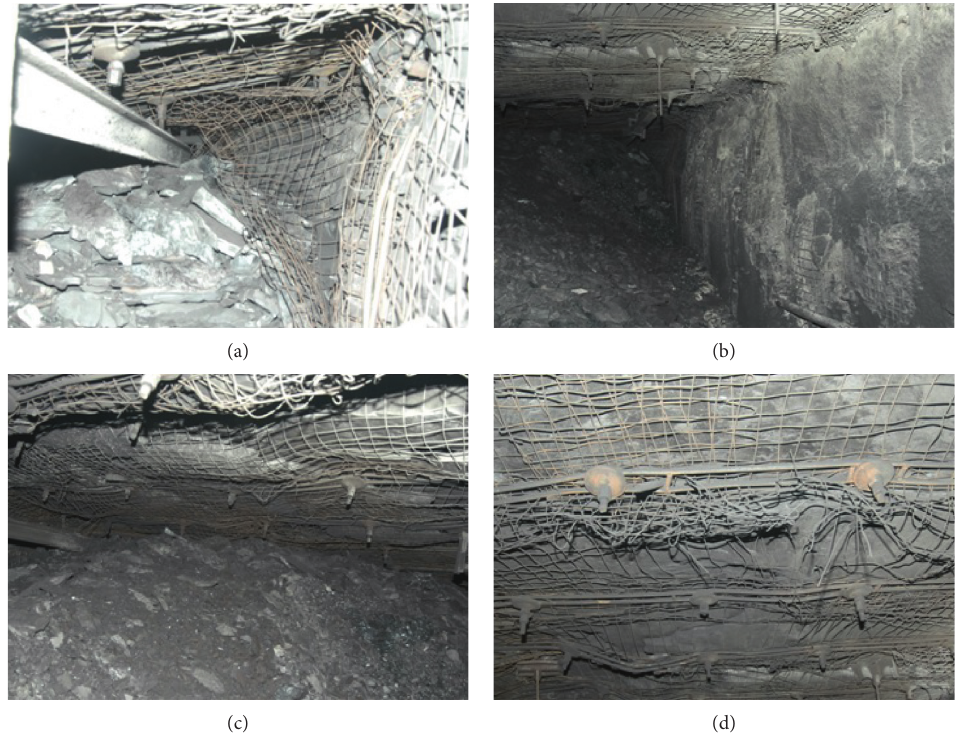
Figure 1: A compound coal-rock dynamic disaster accident: no. 12 coal mine, Pingdingshan Coal Group Co., Ltd.: (a) damage on the roadway supports; (b) the piling of coal flow; (c) the piling of coal flow; (d) normal supports of